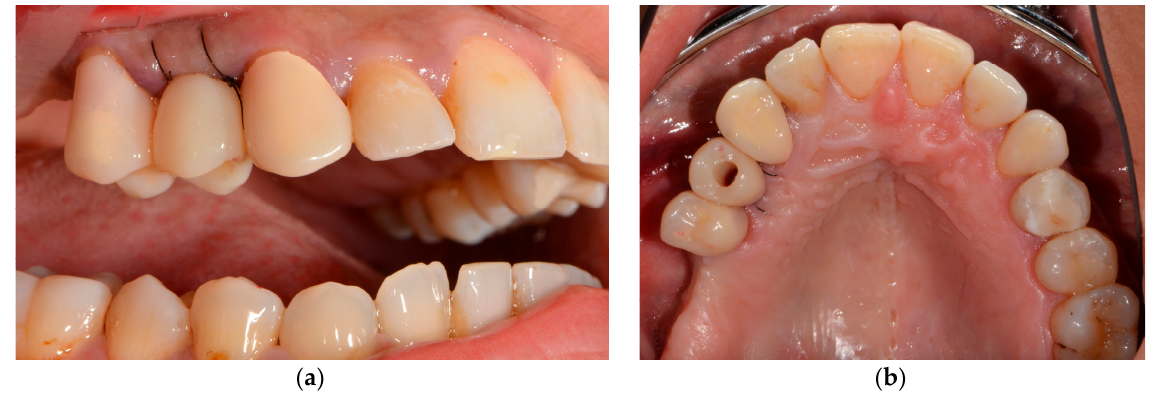
Figure 13. ( a ) Custom-made, temporary chairside restoration of implant 14; lateral view; ( b ) custom- made, temporary chairside restoration of implant 14; occlusal view.